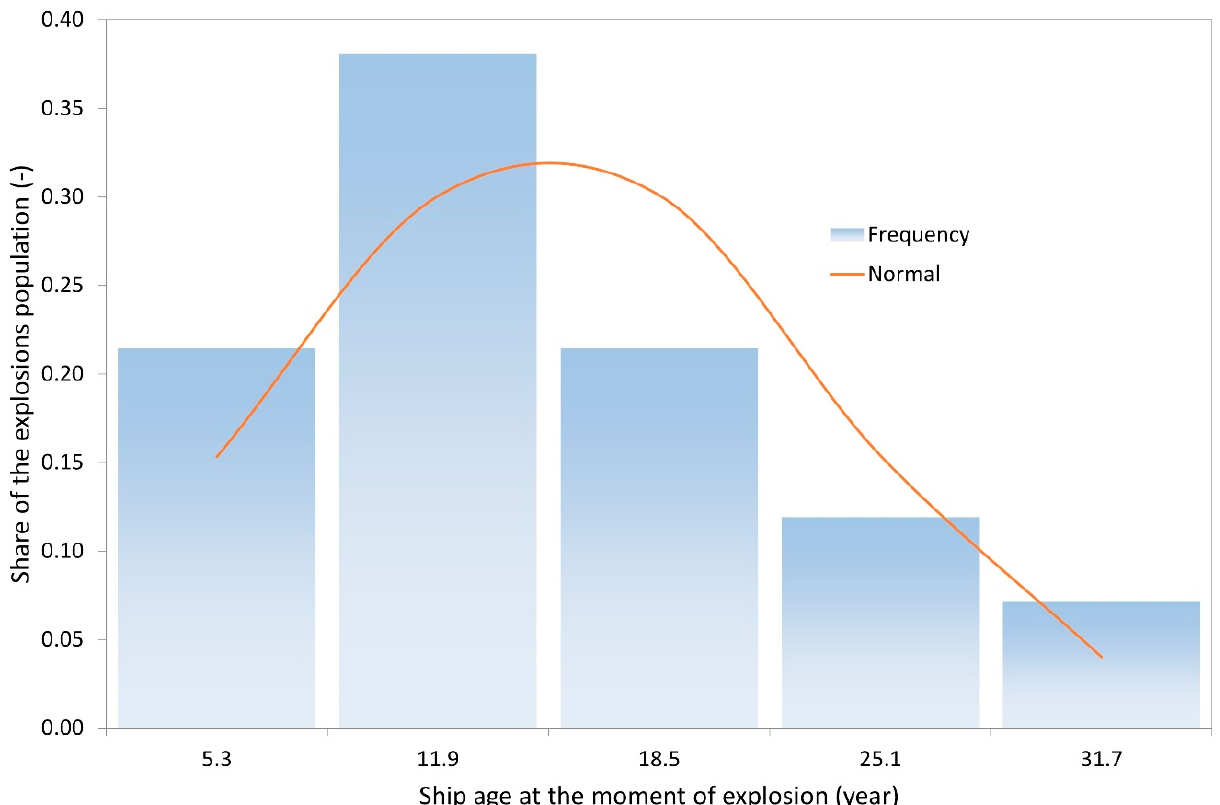
Figure 9. Number of main engine turbocharger explosions as a function of the ship’s age.